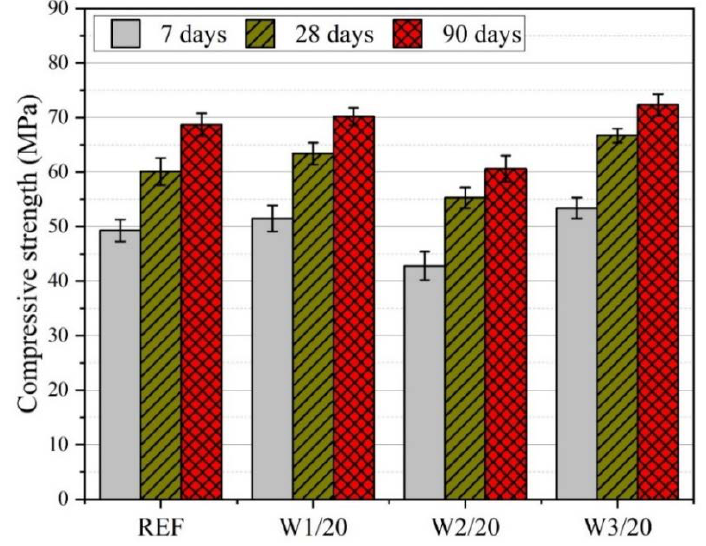
Figure 3. Compressive strength of mortar specimens.